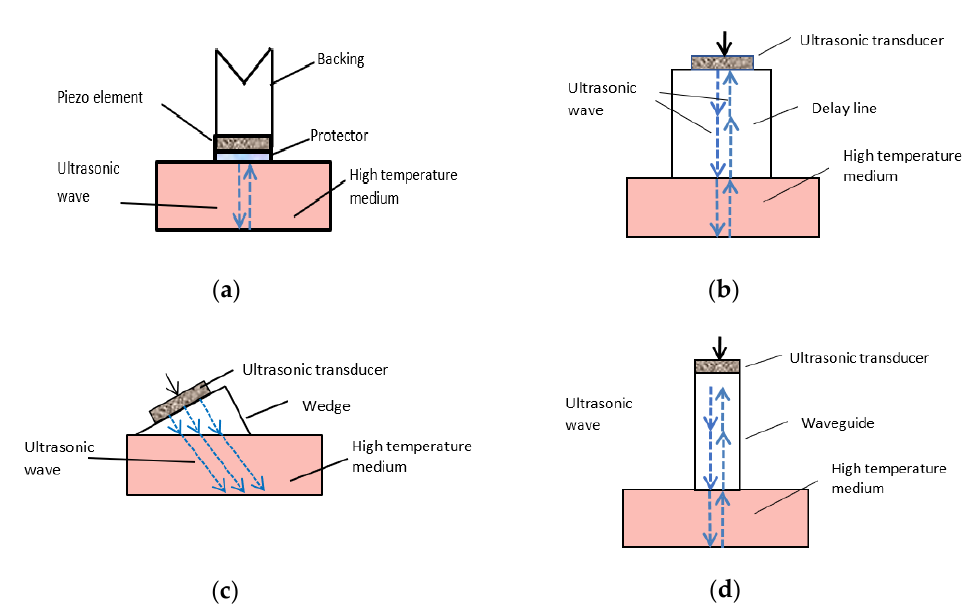
Figure 1. Ultrasonic transducers for extreme conditions: ( a ) with a thin protective layer; ( b ) with a delay line; ( c ) with a wedge; ( d ) with a waveguide.